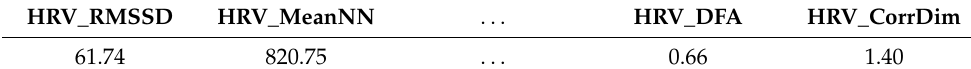
Table 2. The hrv() function returns a dataframe containing all the indices as columns.